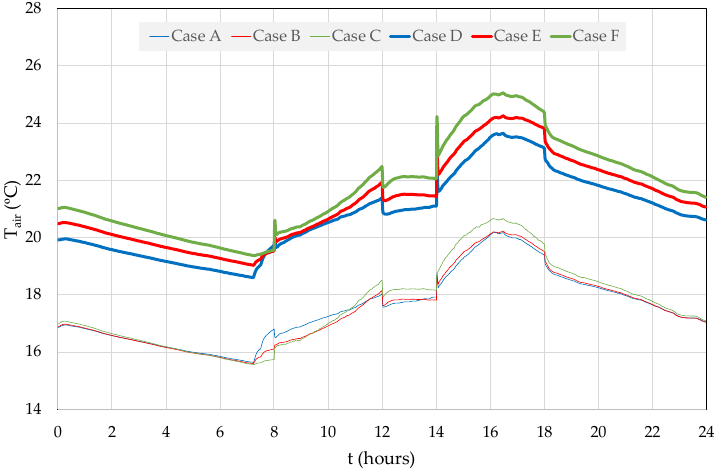
Figure 22. Evolution of internal air temperature (T air ) for the six cases studied.